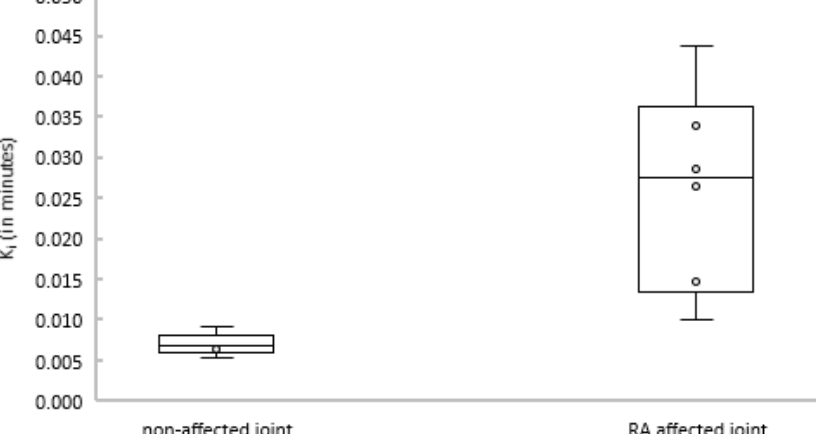
Figure 4. Boxplot depicting Ki estimates for non-a ff ected (left) and rheumatoid arthritis (RA)-a ff ected (right)